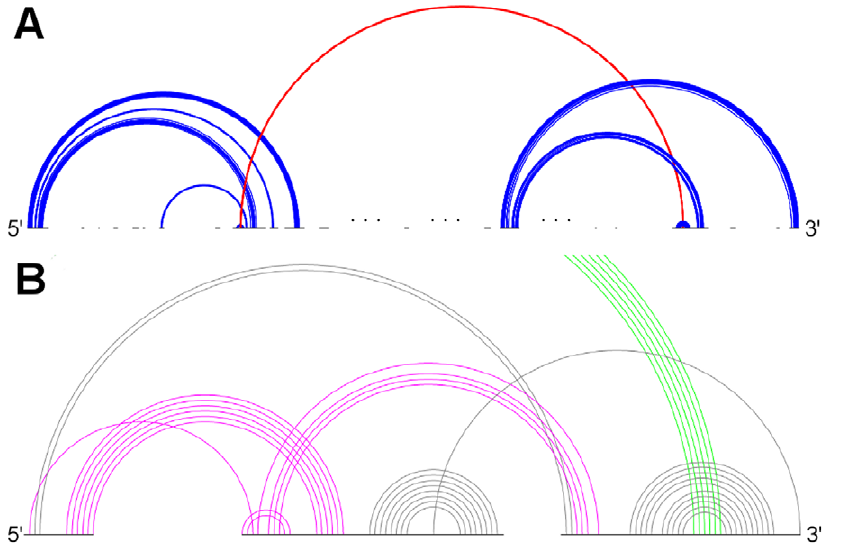
Figure 8. Primitive large kissing hairpin and the G-ribo ring interacting with the large kissing hairpin backbone. A: Large kissing hairpin from RNA sequence PDB_00029 similar to the kissing hairpin backbone. (Stem color, blue: major stem; red: minor stem) B: G-ribo ring (magenta) is crossed with kissing stem (green) through the lone pair and the double pair in CRW_00525 (subclass 3D). doi:10.1371/journal.pone.0039907.g008 PLoS ONE |